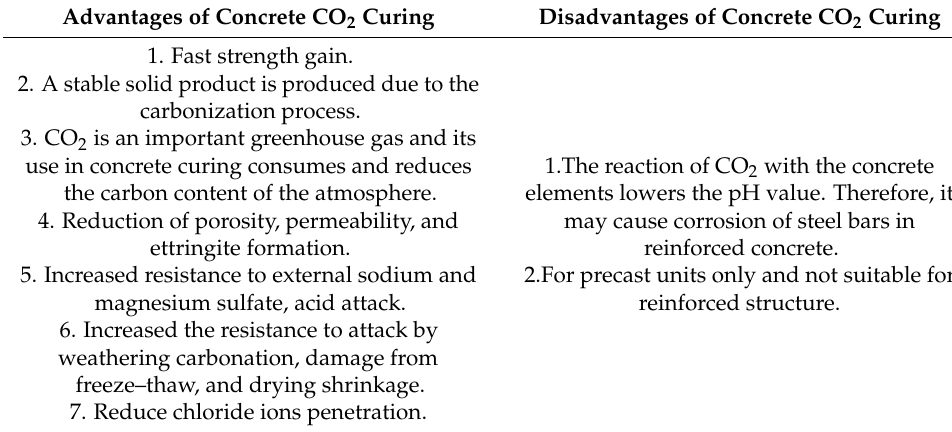
Table 1. Advantages and disadvantages of concrete CO 2